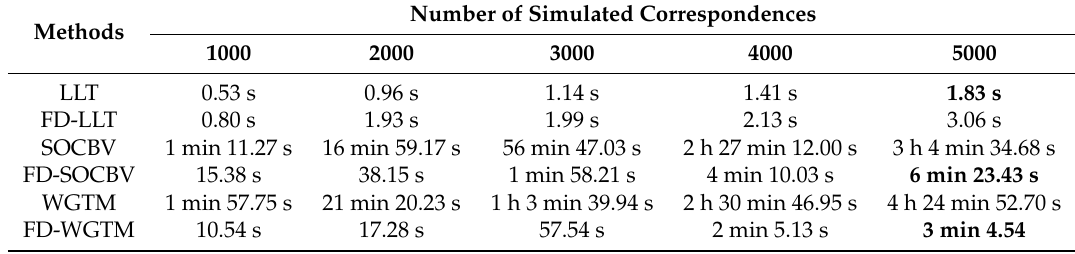
Table 1. Running time comparison of the three matching algorithms on two feature-matching models with varying numbers of